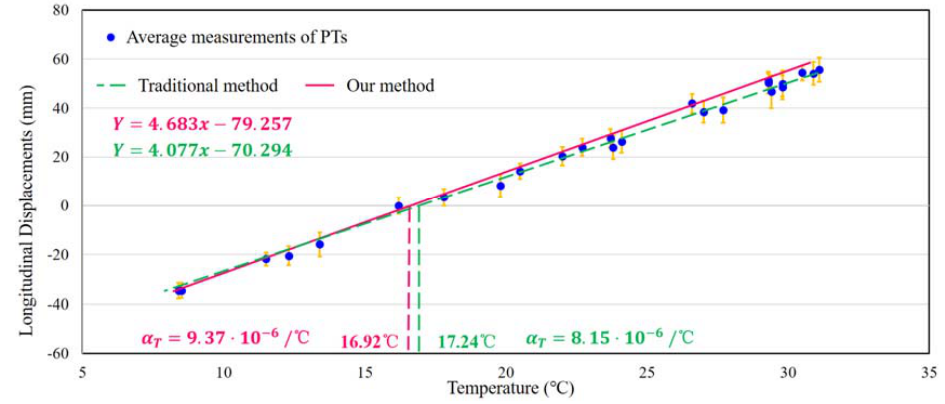
Figure 16. The thermal dilation model of the TKH.